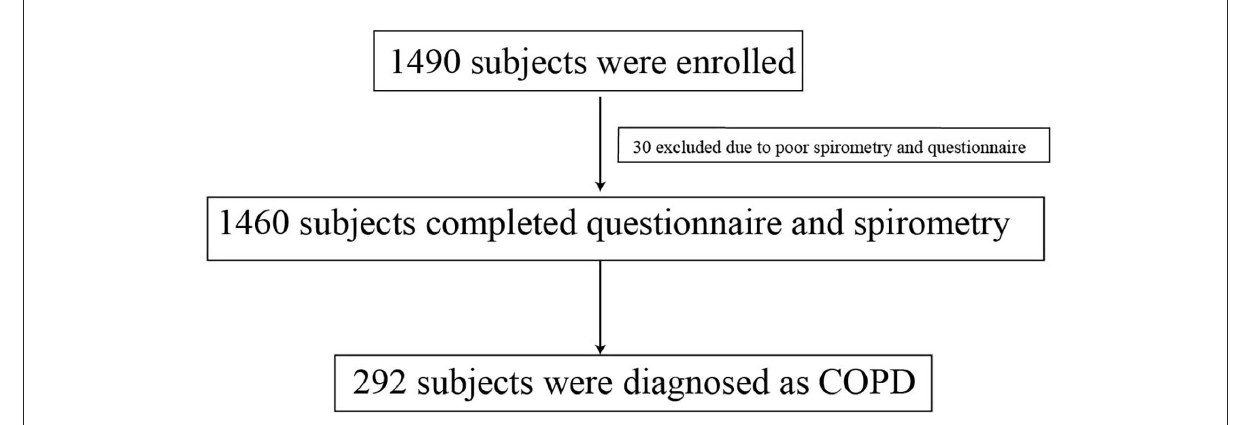
FIGURE2 Flow chart. COPD, chronic obstructive pulmonary